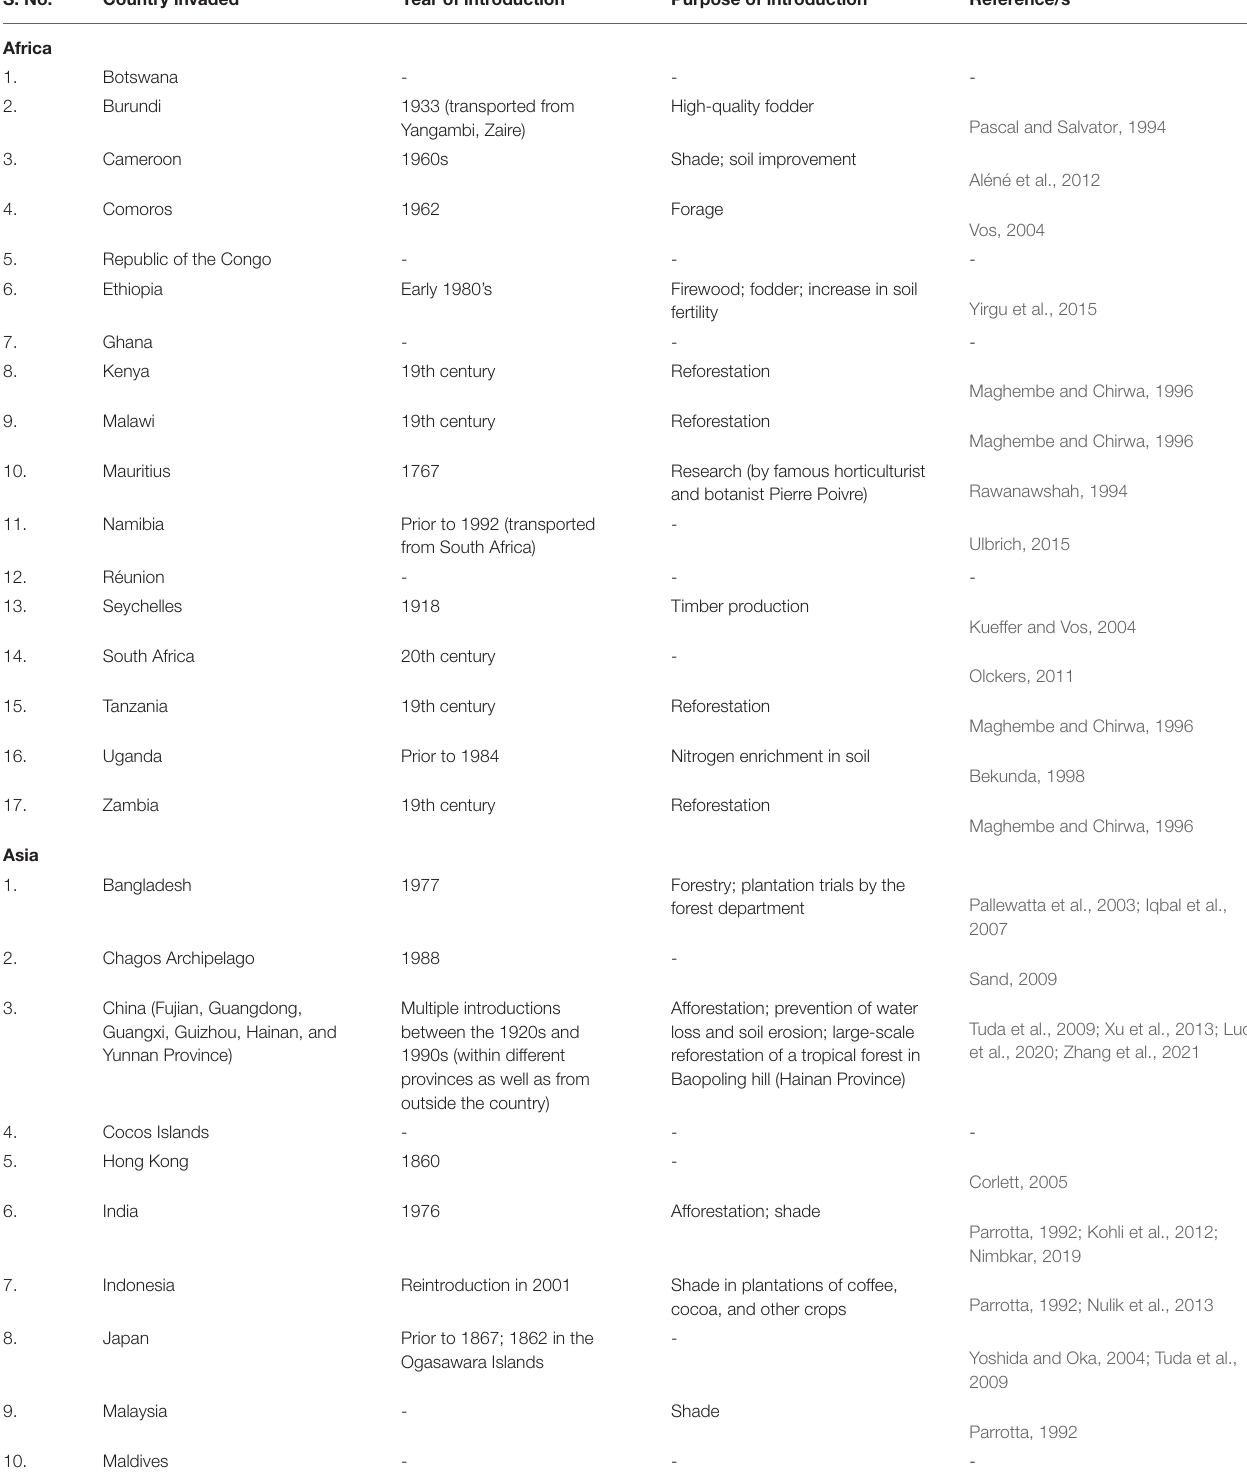
TABLE 2 | List of countries in which Leucaena leucocephala is considered invasive (modified from CABI (2021)). S.